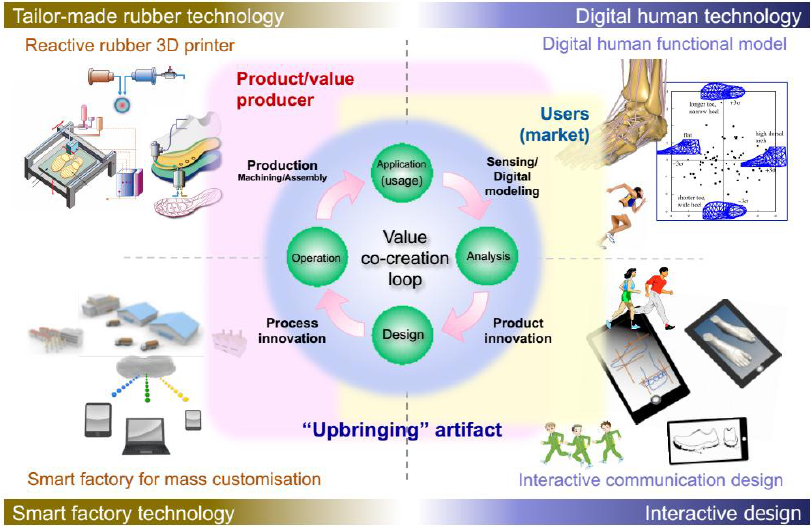
Figure 11. Proposed value co-creation loop.